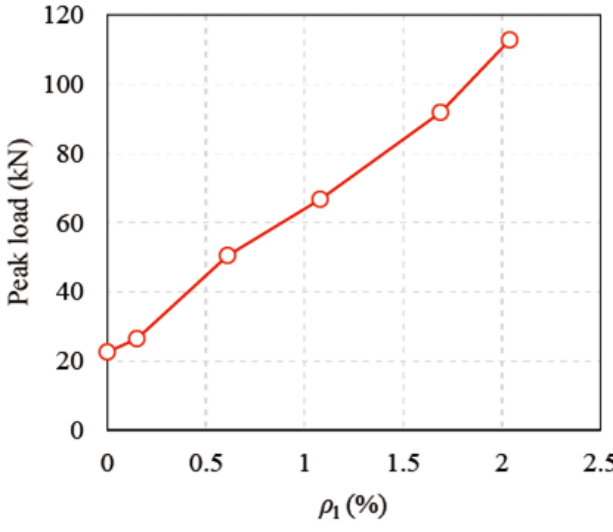
Figure 10. Load vs. mid-span deflection curves.